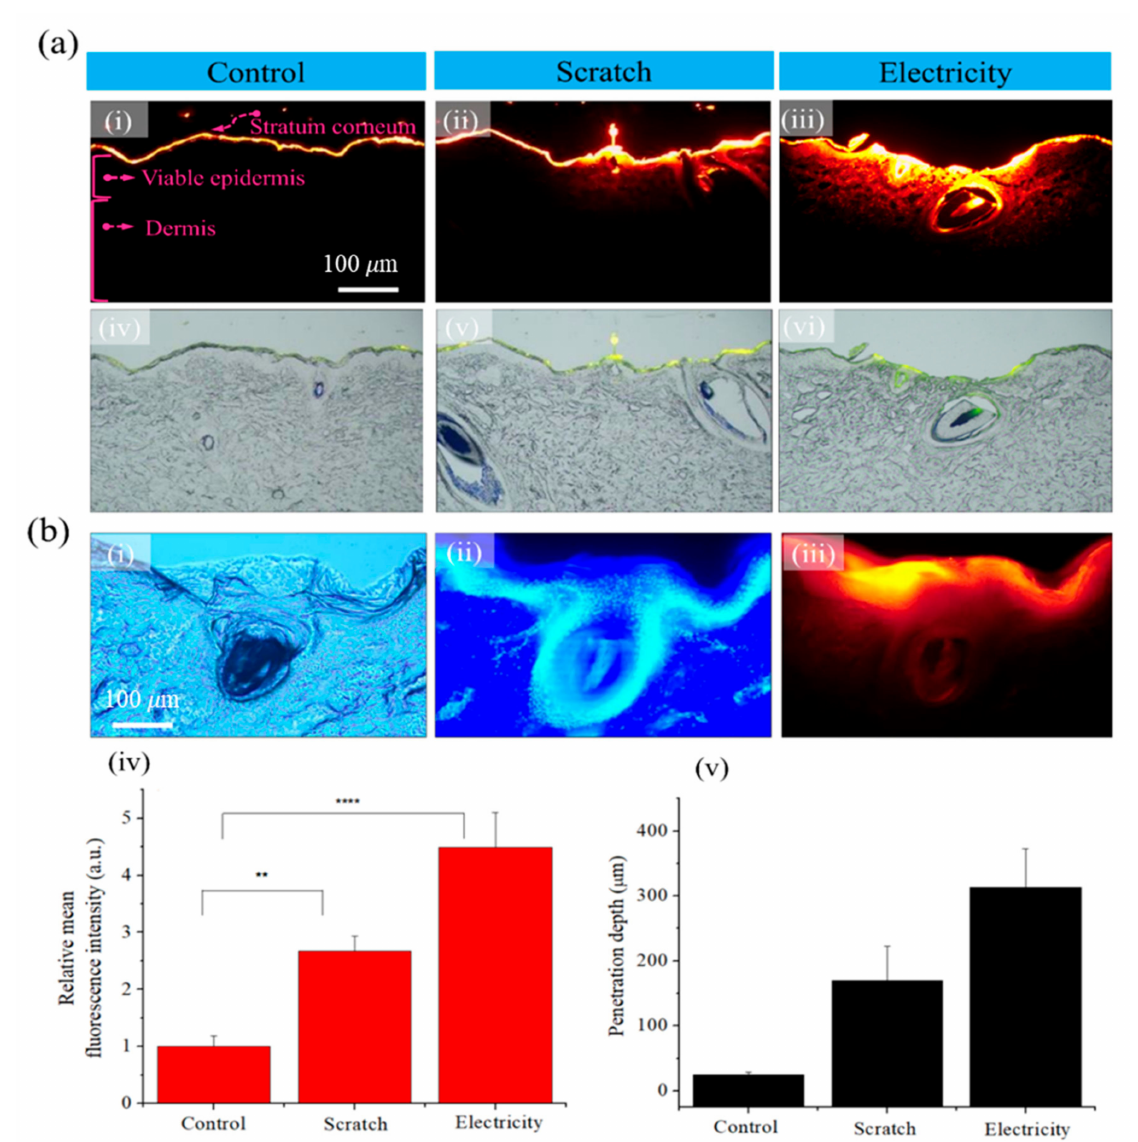
Figure 2. ( a ) Fluorescence and merged optical images. ( i , iv ) Control, ( ii , v ) scratch effects, and ( iii , vi ) electricity effects. ( b ) Magnified images obtained when electricity was applied. ( i ) Bright field image, ( ii ) 4 (cid:48) 6 (cid:48) -diamidino-2-phenylindole staining image, ( iii ) fluorescence image, ( iv ) fluorescence distribution using Image J (here, ** indicates p < 0.05 and **** indicates p < 0.01), and ( v ) penetration depth (the scale bars in ( a-i )–( a-vi ) = 100 µ m and in ( b-i )–( b-iii ) = 100 µ